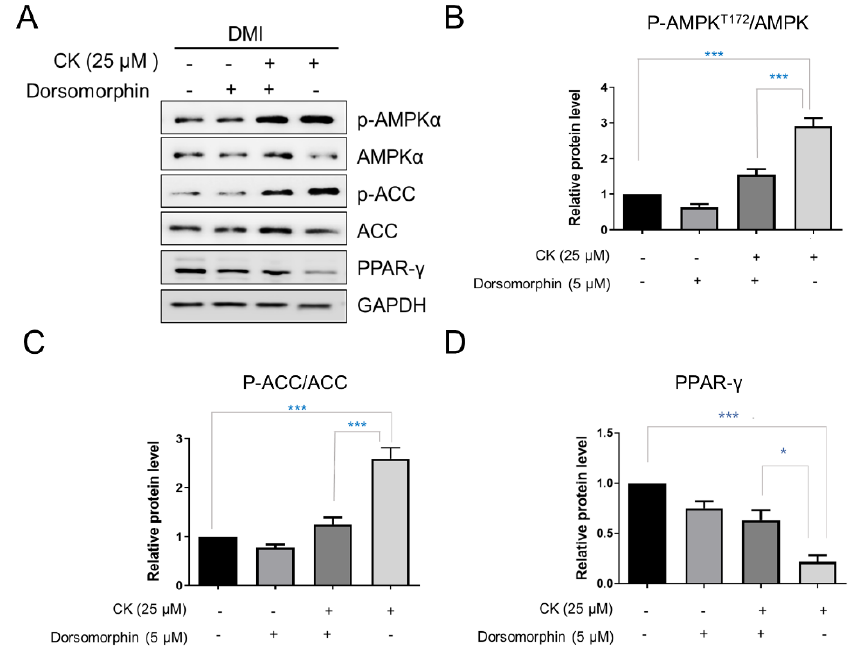
Figure 7. Effect of CK on AMPK signaling pathway. Confluent 3T3-L1 cells, with and without 5 µ M Dorsormorphin, were treated with CK and differentiation was induced for 8 days. ( A ) Expression of p-AMPK, AMPK, p-ACC, ACC, PPAR- γ was analyzed by Western blotting. ( B – D ) Relative protein levels of AMPK ( B ), ACC ( C ), and PPAR- γ ( D ) were measured via densitometry and analyzed using Image J software. Data were expressed as mean ± SD from triplicated experiments. *: p < 0.05, and ***: p < 0.001, significantly different from the differentiated group.